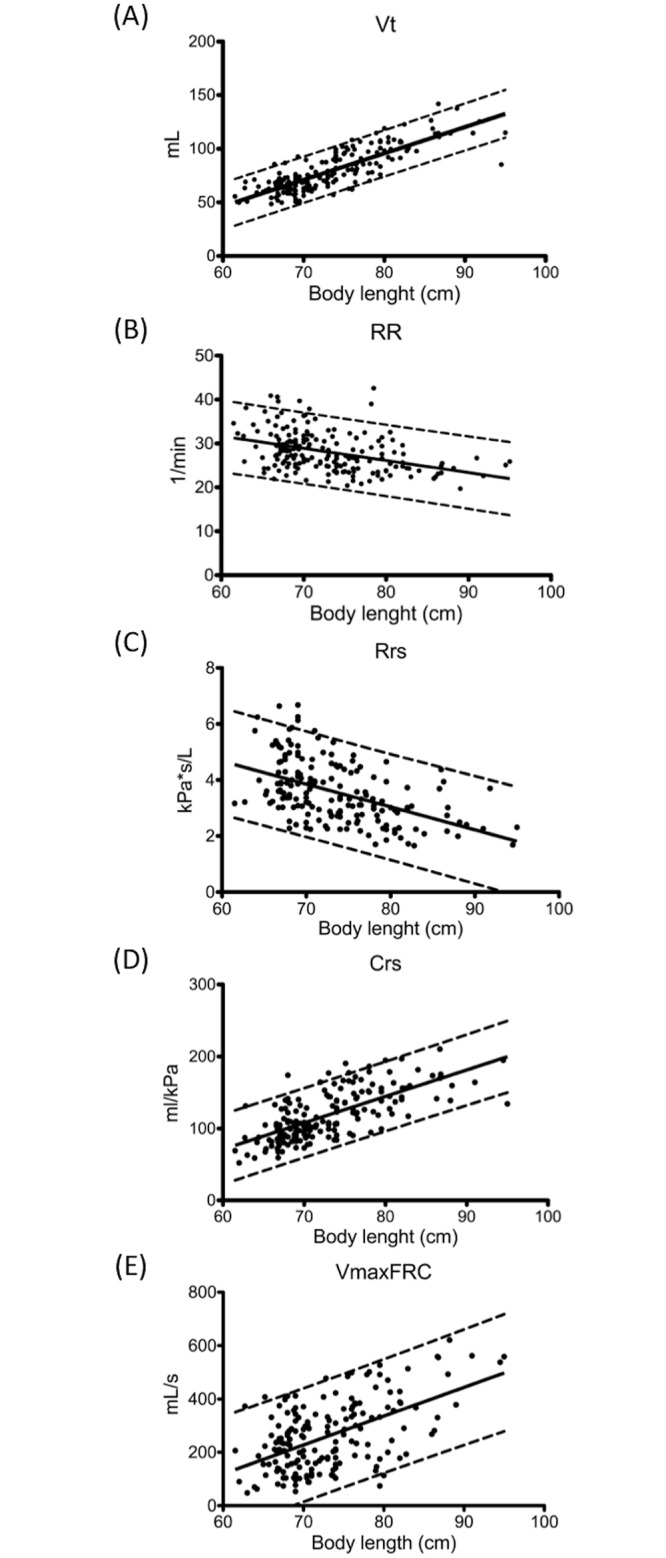
Regression curves of various parameters.Regression curves (means and 95% confidence bands) of various parameters including (A) tidal volume (Vt), (B) respiratory rate (RR), (C) resistance (Rrs), (D) compliance (Crs), and (E) maximal flow at functional residual capacity (VmaxFRC), plotted against crown-heel length at the time of the test.